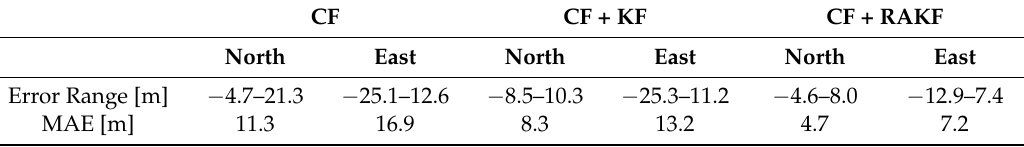
Table 3. Error comparison table in running under different heading estimation algorithm.